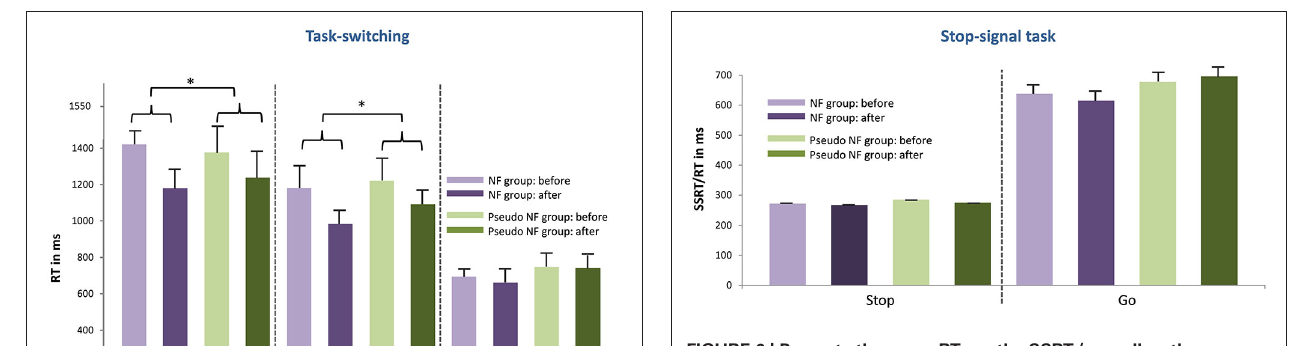
FIGURE 6 | Presents the mean RTs or the SSRT (as well as the standard error of mean) of the stop signal task for the NF group